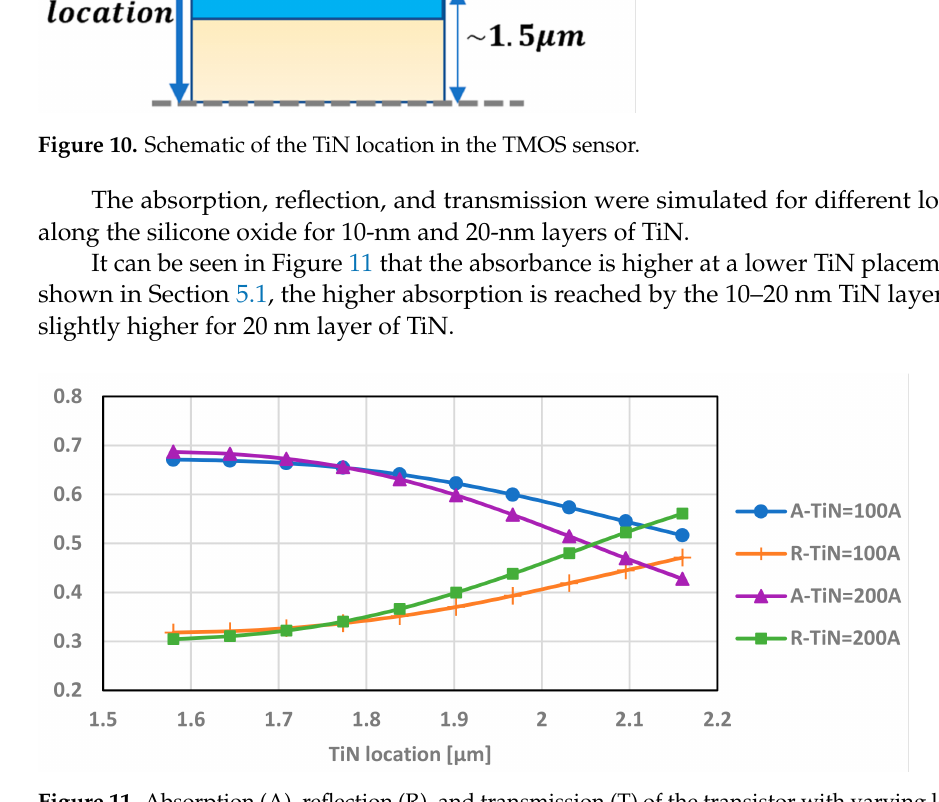
Figure 11. Absorption (A), reflection (R), and transmission (T) of the transistor with varying locations of the TiN layer along the upper silicon oxide for 10-nm and 20-nm layer thickness. This simulation is performed at a 9.5- µ m